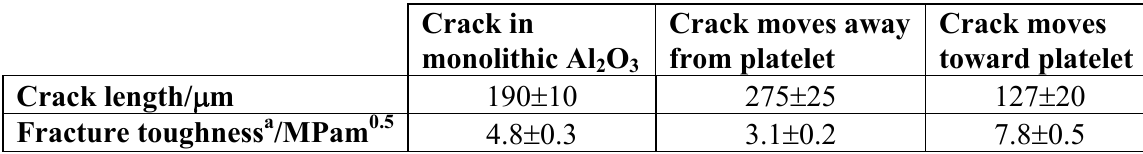
Table 3. Anisotropic toughening effect near a